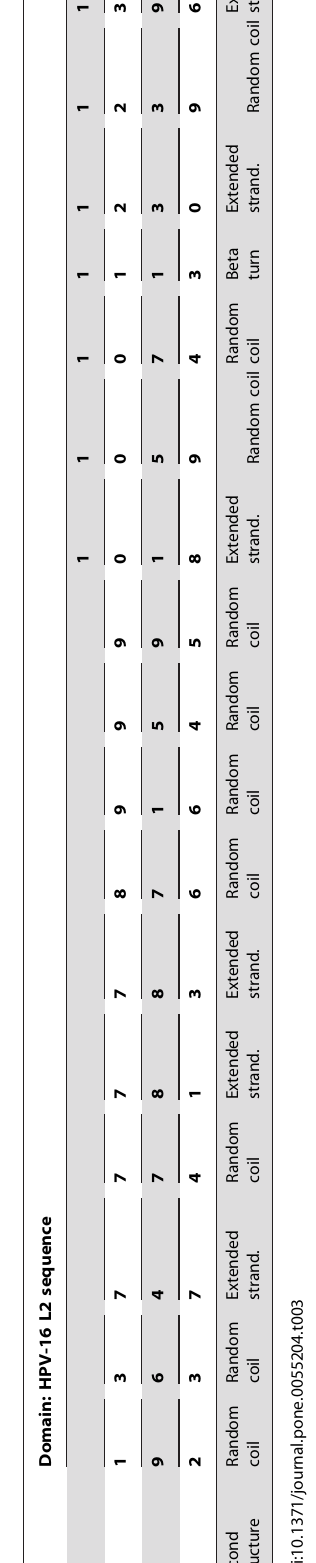
Medical Biology for HPV DNA amplification. HPV typing of these specimens was performed using a nested multiplex PCR assay as described previously [15,16]. HPV-16 (L1: n= 31; L2: n =28), HPV-58 (L1: n= 21; L2: n= 21) sequences thereby obtained were used for molecular characterization by sequence analysis of the L1 and L2 gene. Nucleic acid extraction and sequencing amplification Molecular characterization was performed by sequence analysis of L1 and L2 gene amplicons. The entire region of L1 and L2 genes of HPV-16 and HPV-58 were amplified using degenerate primer pairs. Two partially overlapping fragments for each virus were amplified. All Primers were designed and synthesized by Sangon Biotech (Shanghai). The GeneBank reference sequences used for primer design were HPV-16 (NC001526 [17]) and HPV- 58 (HQ537759). The primer sequences and their relative positions are listed in Table 1. The amplification of the fragments was performed in 50 ul reaction volumes containing 5 ul extracted DNA (template), 2 6 power taq PCR MasterMix (TaKaRa), T